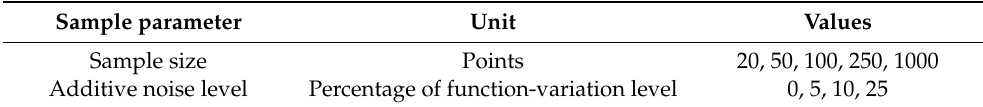
Table 2. Parameters of samples for test